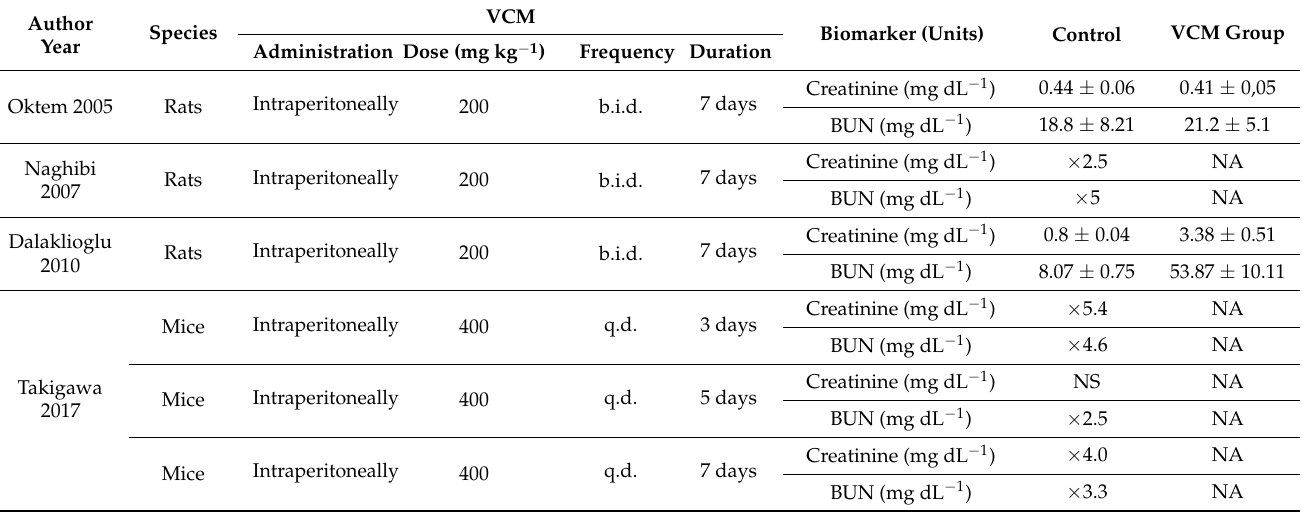
Table 1. Major blood biomarkers in animal studies of vancomycin-induced acute kidney